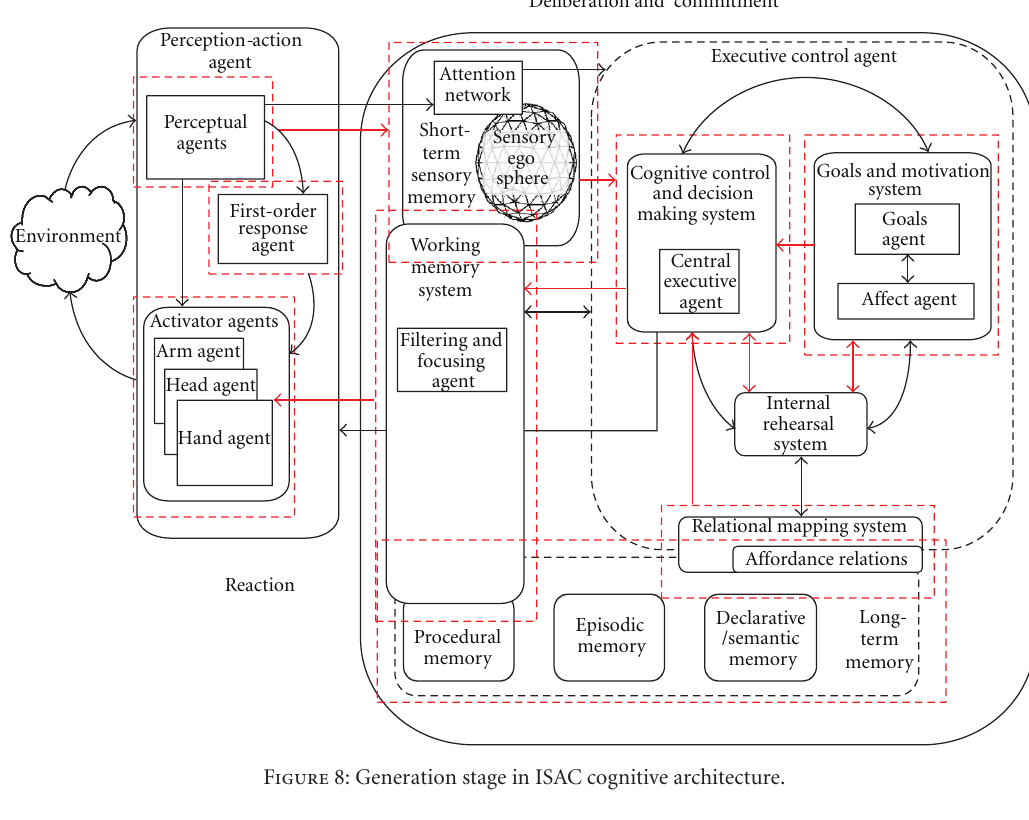
Figure 8: Generation stage in ISAC cognitive architecture.